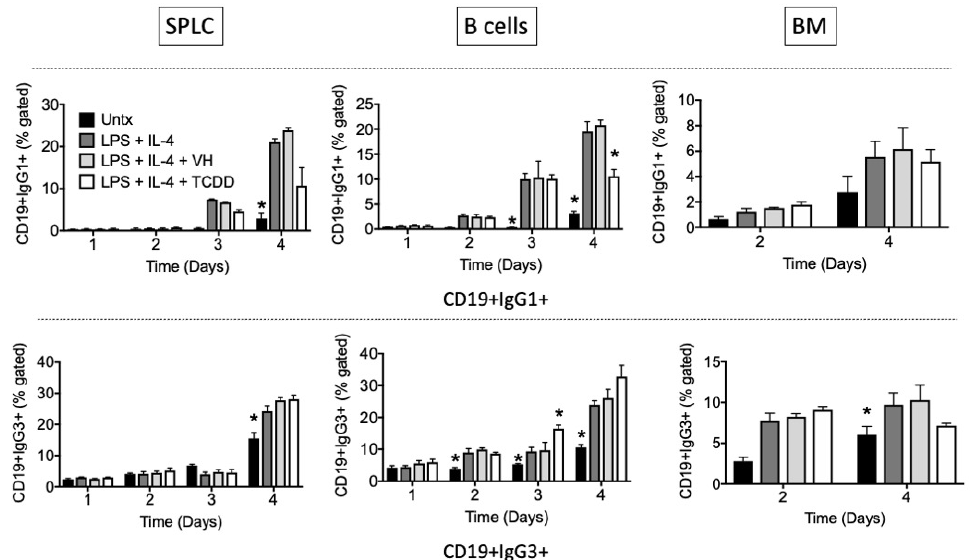
on IgG3, except for stimulation of an IgG3+ population at day 3 in B cells (Figures 8–10).